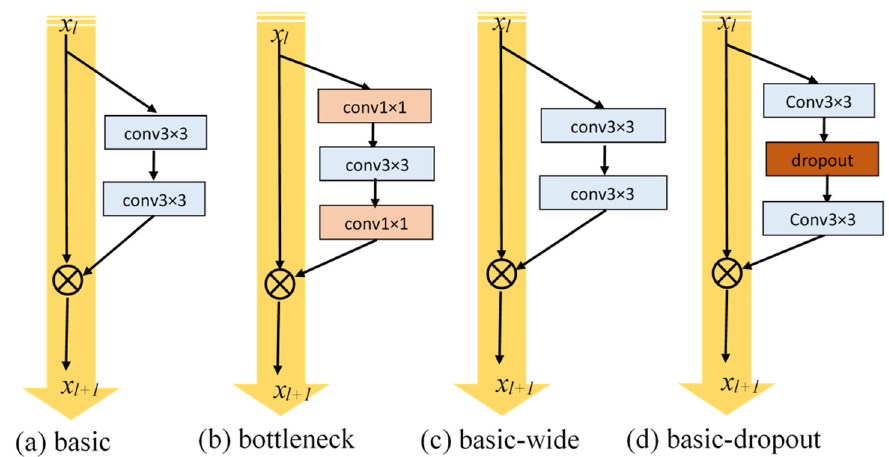
Figure 6. Differences between ResNet and Wide ResNet designs. ( a , b ) residual blocks used in ResNet; ( c , d ) residual blocks used in Wide ResNet.